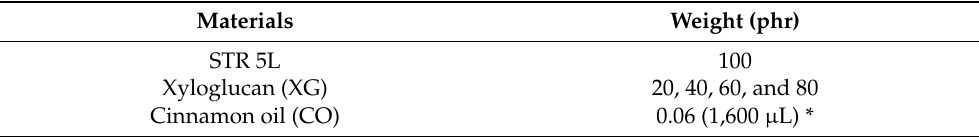
Table 1. Recipe and mixing conditions for the bio-based pressure-sensitive adhesives patch incorpo- rating cinnamon oil (Bio-PSA/CO) patches